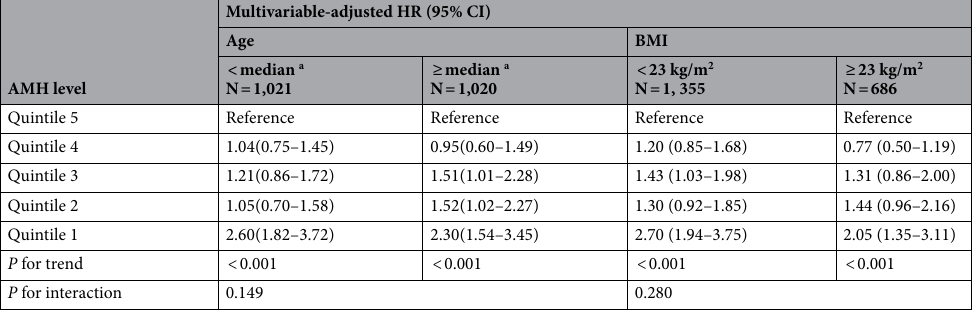
Table 3. Incident early-onset vasomotor symptoms according to AMH quintiles in clinically relevant subgroups. a Median of age—44.27. Parametric proportional hazard models were used to estimate the hazard ratios with 95% confidence intervals. The multivariable model was adjusted for age, menopause stage, menarche age, education level, parity, physical activity, smoking status, body mass index, and alcohol intake. The likelihood ratio tests comparing models with and without multiplicative interaction terms to evaluate the interactions. Abbreviation: AMH, anti-Müllerian hormone; CI, confidence interval; HR, hazard